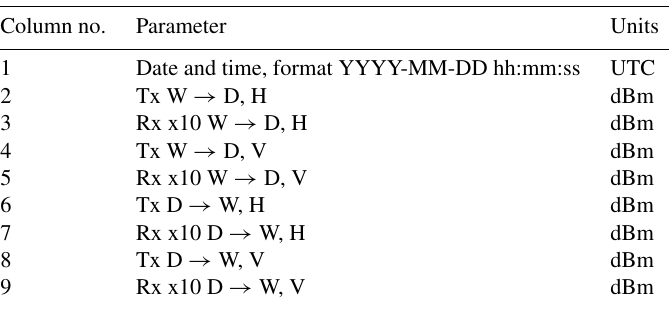
Table E1. Measured CML parameters.